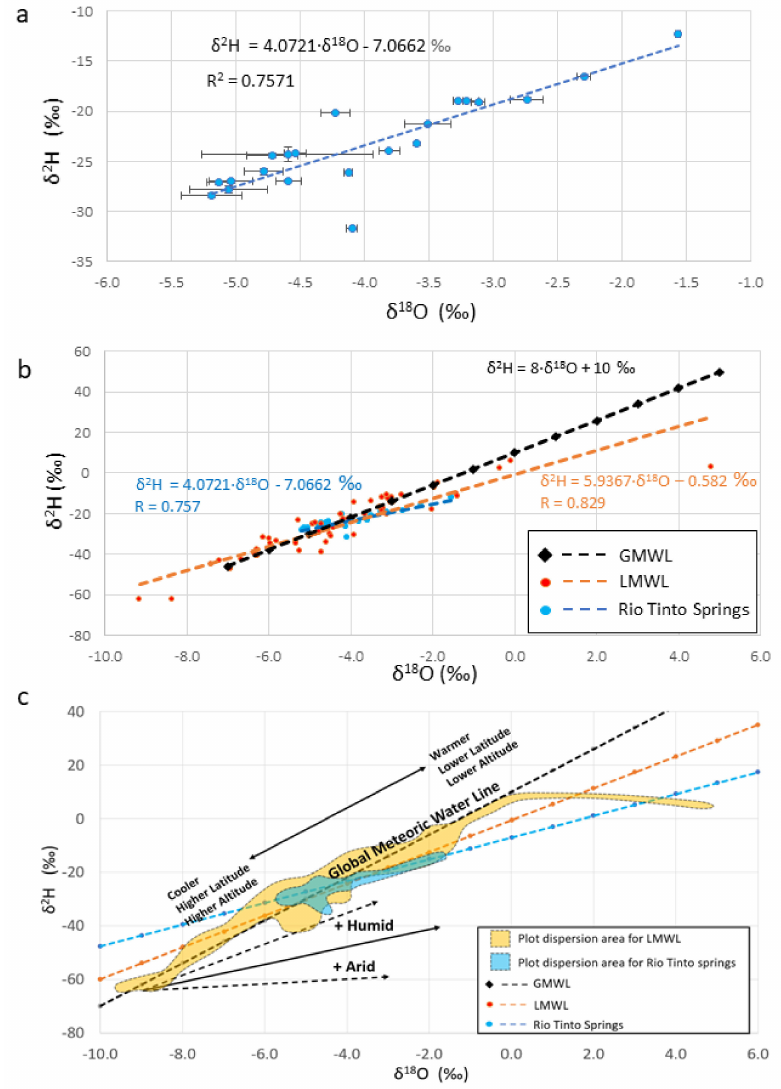
Figure 11. Different scatterplot showing the distribution and regression of δ 18 O and δ 2 H in the Rio Tinto headwater springs compared to the Global Meteoric Water Line (GMWL) and the Lo- cal Meteoric Water Line (LMWL), obtained from data collected in the Moron Base and Seville (www-naweb.iaea.org, accessed on 16 March 2015). ( a ) δ 18 O and δ 2 H regression from Springs throughout the Rio Tinto Headwaters Graph plotting values for all of the samples from Rio Tinto, where the 2 standard deviation error bars were added on to each plot. ( b ) Rio Tinto Isotopic Results in Comparison to the GMWL and LMWL. ( c ) Plot the local and global mete- oric water line in addition to the Rio Tinto plots, with the data field being added, highlighting each distribution pattern. Data sourced from: SAHRA—Isotopes & Hydrology. Available at: http://web.sahra.arizona.edu/programs/isotopes/oxygen.html#1 (accessed on 5 March